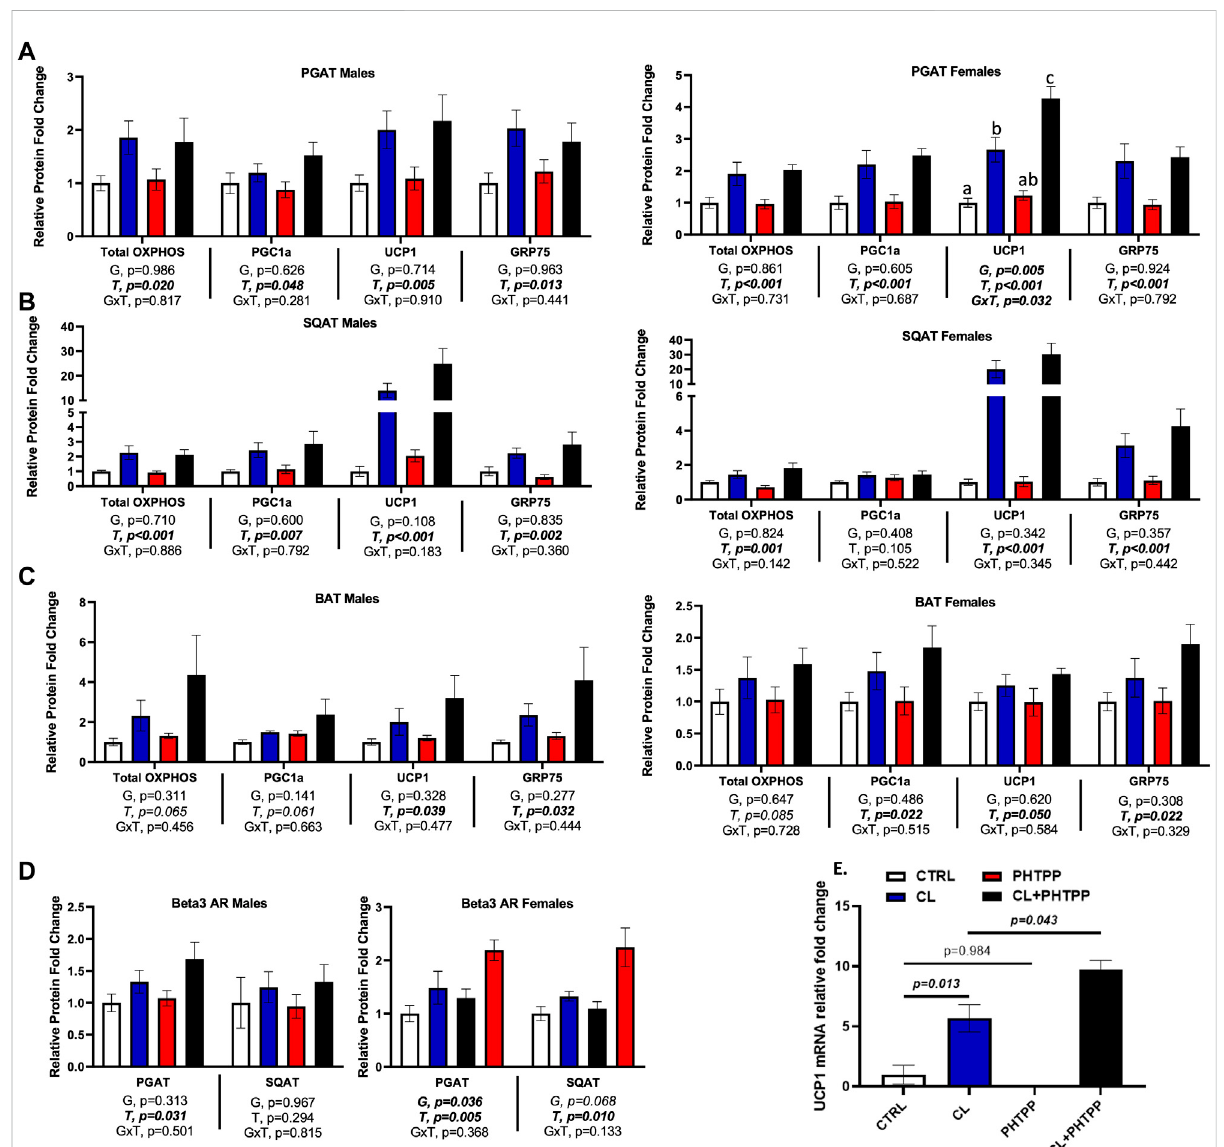
FIGURE 5 In vivo and in vitro , suppression of ER β genomic activity increases WAT sensitivity to CL-induced UCP1. Male ( left panels ) and female ( right panels ) C57BL/6J wild-type (WT) or Estrogen Receptor Beta (ER β ) DNA binding domain knockout (ER β DBD KO) mice, all on HFD, were given 2-weeks CL injection (1ug/g body wight) or CTRL (saline). Perigonadal (PGAT), subcutaneous (SQAT) and brown (BAT) adipose tissue depots were collected and the expression of mitochondrial proteins were measured via western blot. Total OXPHOS (Combined markers for complexes 1-5 of the oxidative phosphorylation proteins); PGC1a (Peroxisome Proliferating Receptor Gamma Coactivator 1 alpha protein); UCP1 (mitochondrial uncoupling protein 1); GRP75 (Glucose-response protein 75); beta actin uses as normalizer protein. (A) PGAT protein expression (B) SQAT protein expression (C) BAT protein expression (D) β 3-adrenergic receptor ( β 3AR) protein expression; relative to beta actin (E) Primary adipocytes harvested from PGAT and SQAT samples extracted from non-treated male C57BL6J wild-type mice were treated in vitro with either 1 uM CL, 1 uM of the ER β selectiveantagonist,PHTPP( i.e.,chemicalinhibitorofER β genomicactivity )or1uMofthecombinationofCLandPHTPP.After24 htreatment,Ucp1 mRNA induction was measured using qRT-PCR relative to beta-actin; forward primer (5 ′ -3 ′ ): CACGGGGACCTACAATGCTT; reverse primer (5 ′ -3 ′ ): ACAGTAAATGGCAGGGGACG; ncbi ref seq: NM_009463.3. All data are presented as mean ± SEM, relative to the WT CTRL. N = 7-9 per group ( in vivo )and8pergroup( invitro